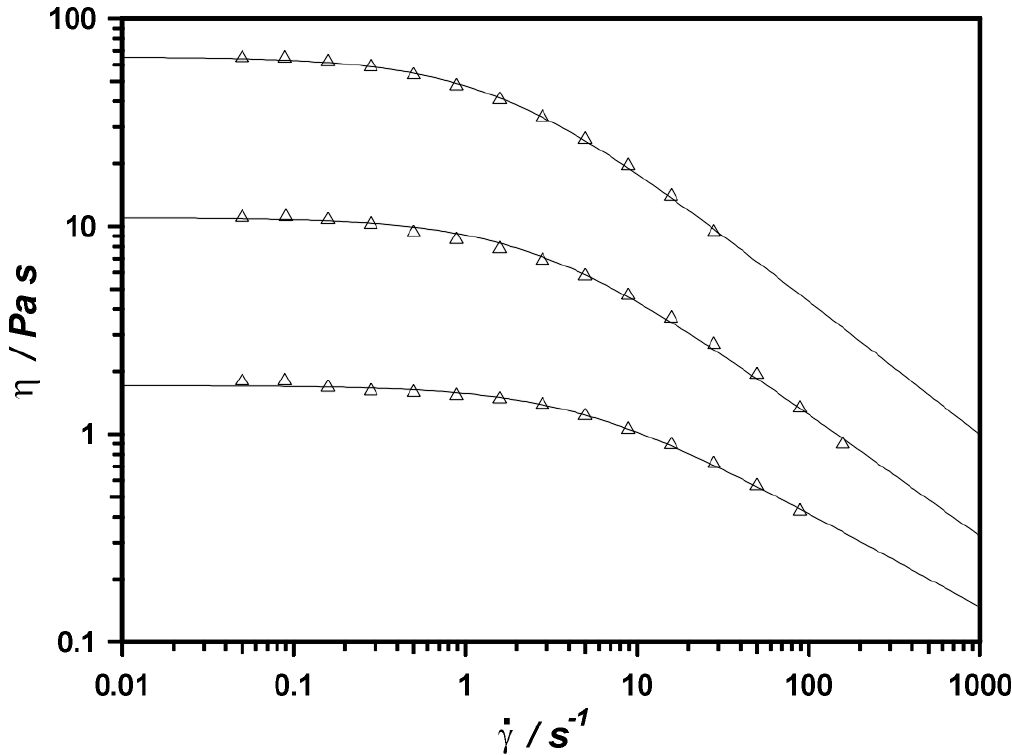
FIGURE 6. Flow curves for a typical polysaccharide entanglement network system.